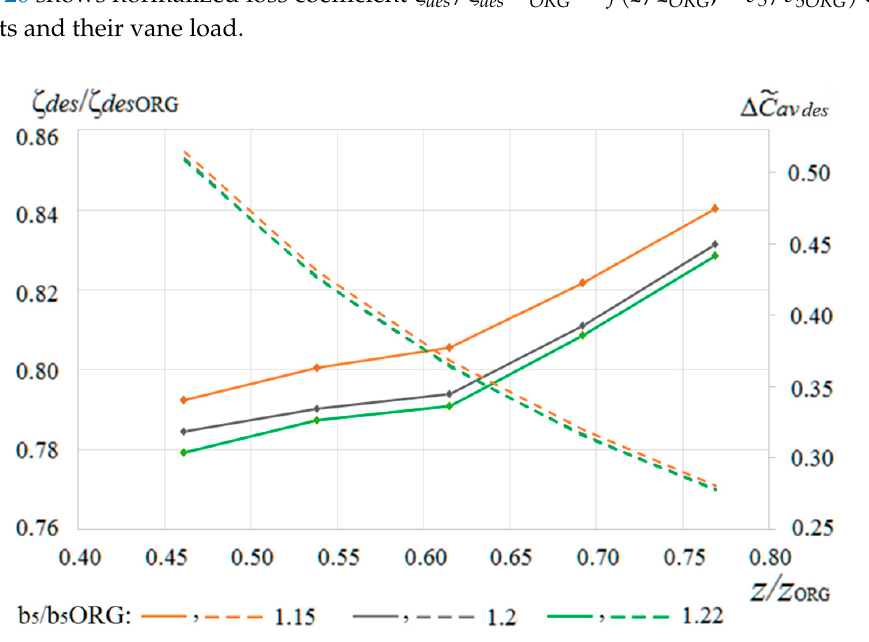
Figure 21. The loss coefficient characteristics of the return channel after preliminary design and of the optimized variants with different numbers of vanes. Unlike the stage with Tdes ψ